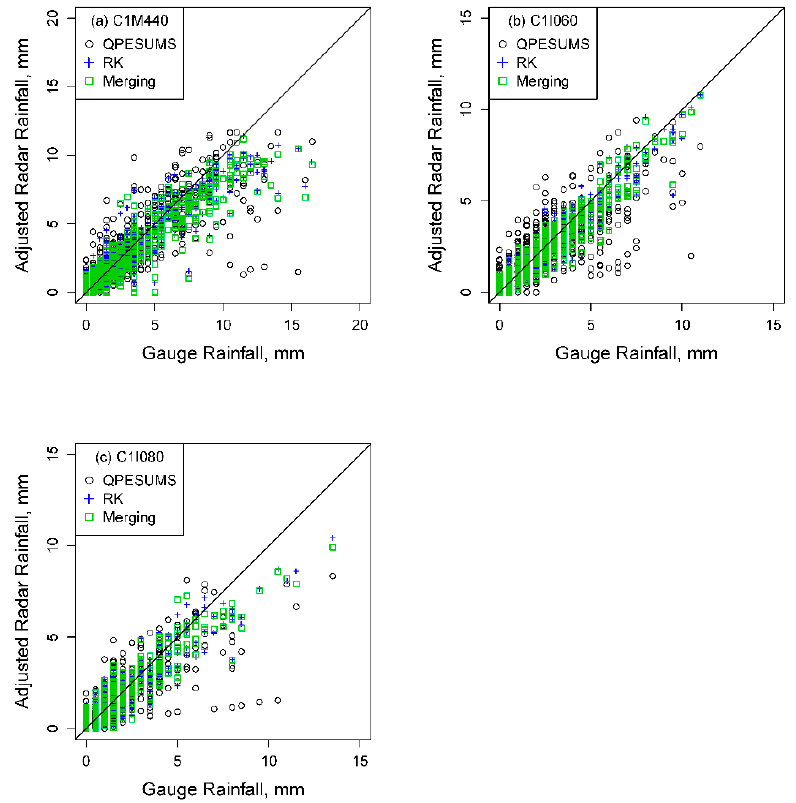
Figure 9. Comparison plots between the gauge measurements and rainfall data from RK, merging, and QPESUMS at (a) C1M440, (b) C1I060, and (c) C1I080 for the event of Typhoon Morakot.